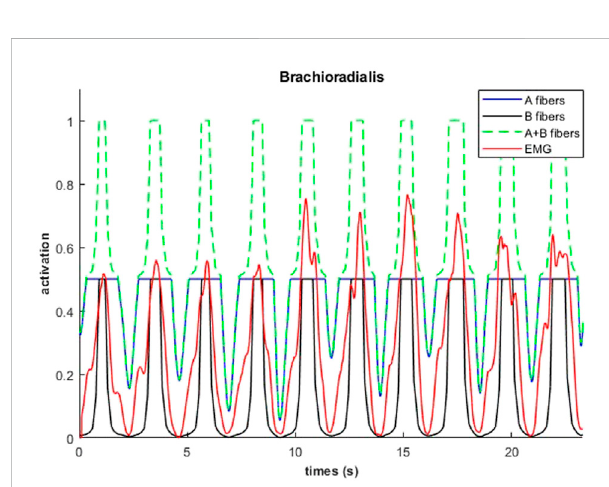
FIGURE 11 Muscular activations obtained through 14M model (distinction between fi bersoftypeAandB),andEMGsignals,duringaweightlifting set of 10 repetitions, using physiological